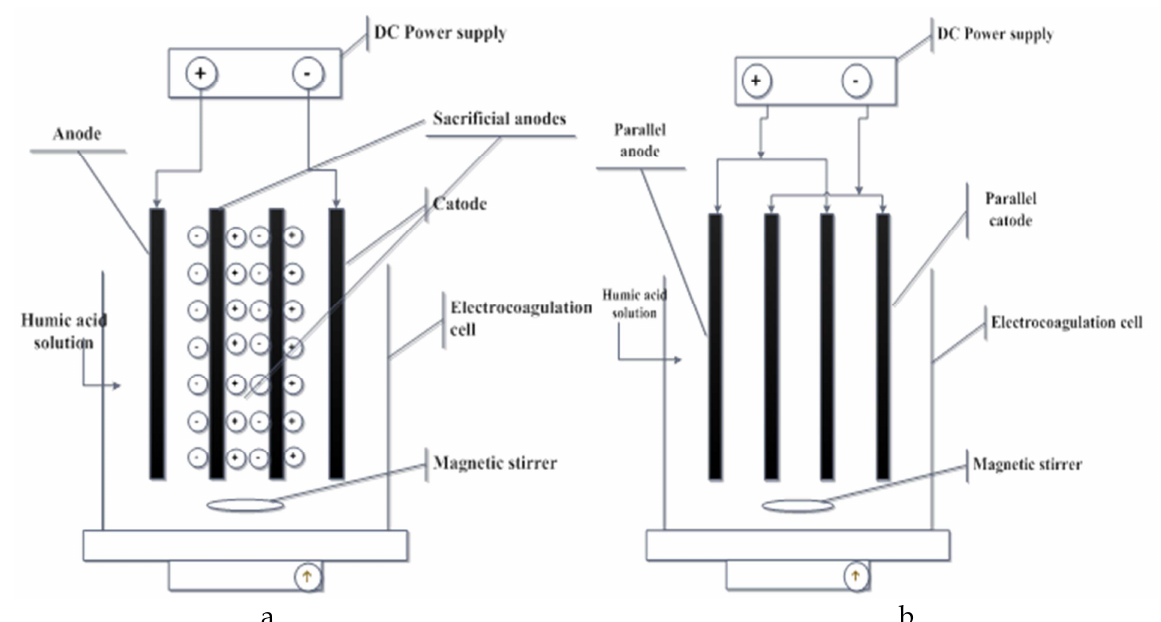
Figure 2. The electrodes arrangement inside the reactor: bipolar (a) and monopolar